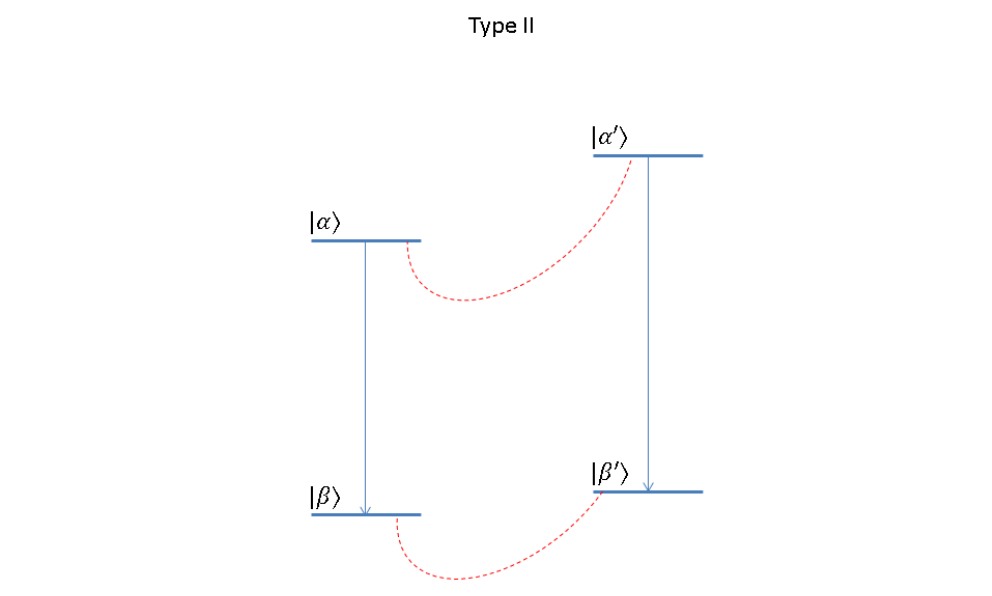
Figure 5. Atomic schemes corresponding to interference terms of the collision operator (type